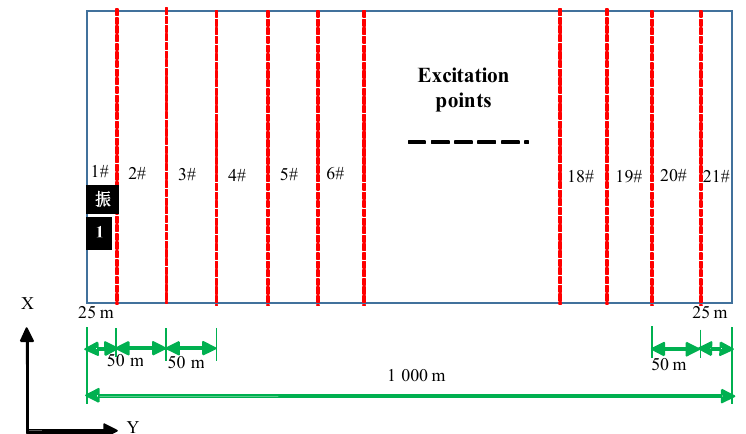
Figure 4. The input method of non-uniform seismic.